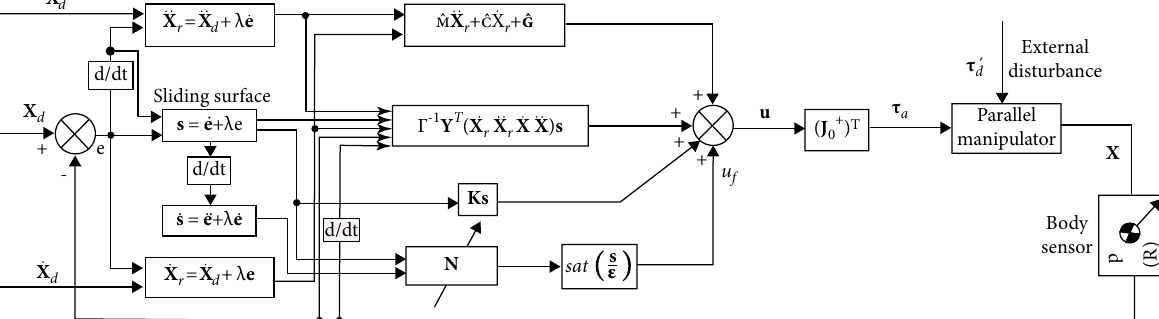
Figure 8: Diagram of adaptive fuzzy sliding mode control system.